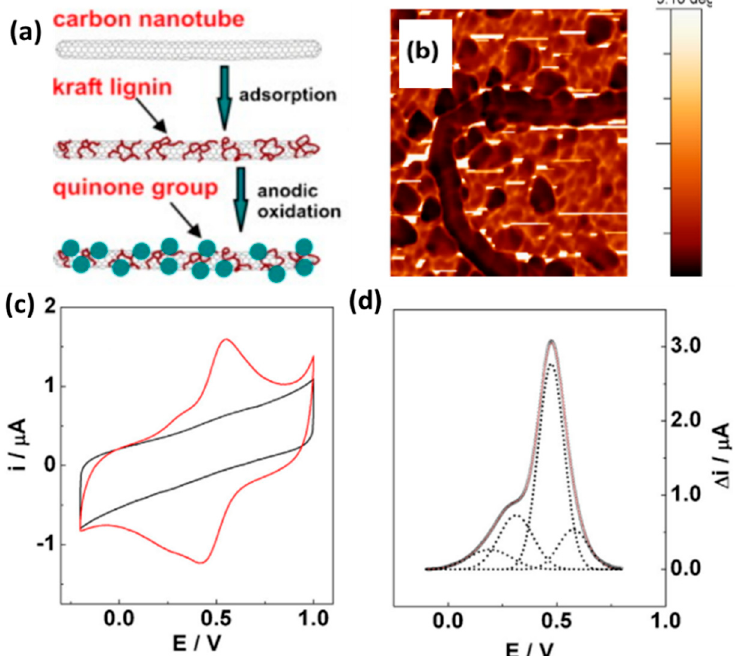
Figure 5. ( a ) Schematic representation of the fabrication of CNT/KL nanocomposites. ( b ) AFM phase-contrast image of KL-functionalized CNTs; image size: 0.6 µm × 0.6 µm. ( c ) CV traces of unmodified (black) and KL-functionalized (red) CNTs, recorded at 50 mV s − 1 . ( d ) Anodic differential pulse voltammogram of an CNT/KL-modified Au electrode, deconvoluted into Gaussian components. Reprinted with permission from Ref. [31]. Copyright 2013 Elsevier.